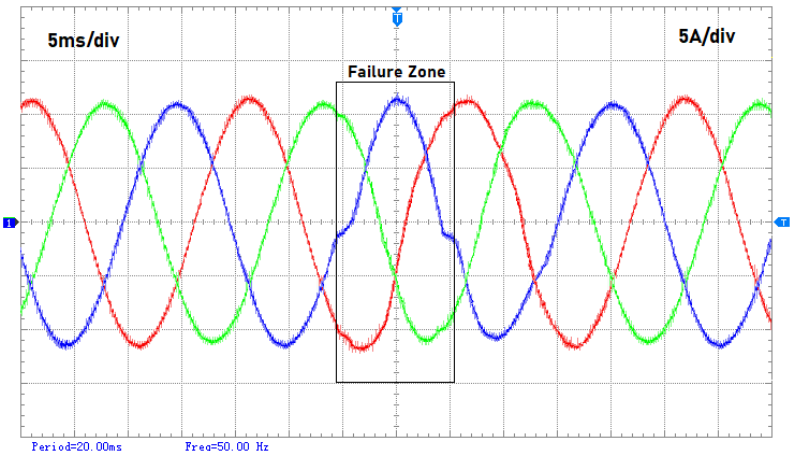
Figure 5. Experimental inverter three-phase currents: ( a ) for a permanent fault in transistor T 1U ; ( b ) for an intermittent fault in transistor T 1 U .